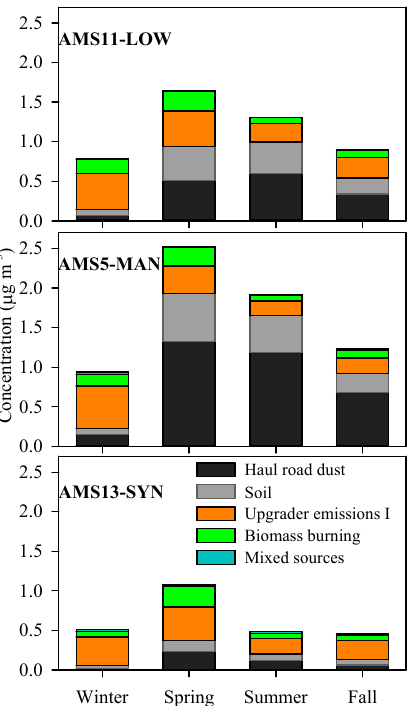
Figure 4. Average seasonal contribution at the three sites from the combined long-term filter campaign data. The contributions are averaged by the season: winter (21 December–19 March), spring (20 March–20 June), summer (21 June–21 September), and fall (22 September–20 December) from 16 December 2010 to 29 November 2012.